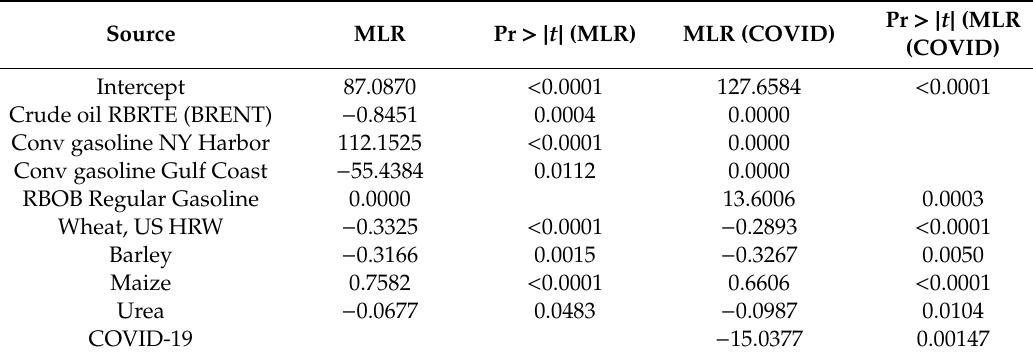
Table 5. Major influencing factors of US ethanol prices.